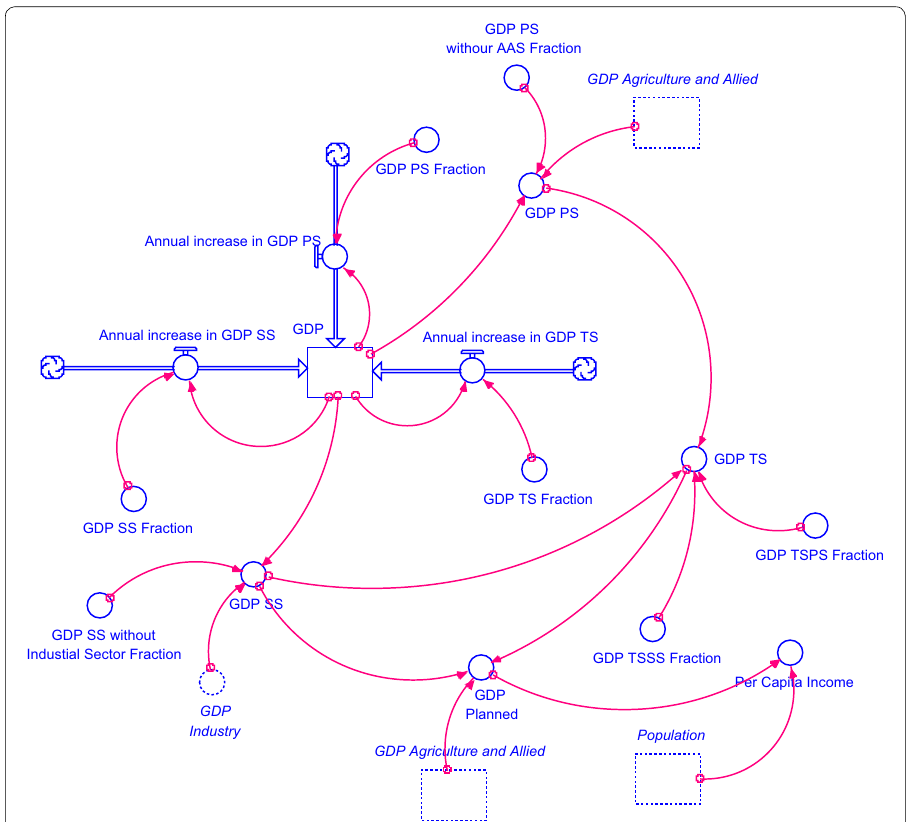
Fig. 8 Diagram showing system dynamics model for sectorwise Gross Domestic Product, and per